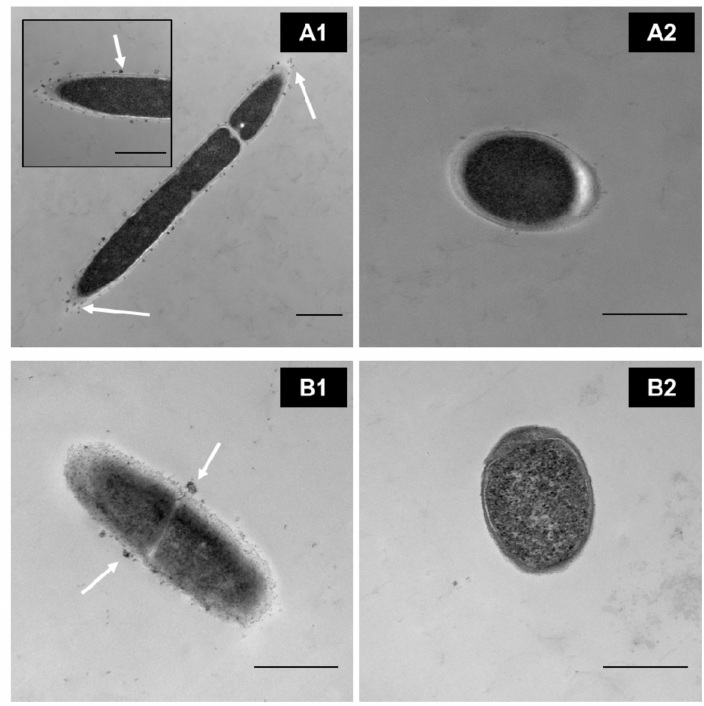
Figure 4. TEM images of washed cells grown in a defined medium supplemented with 0.5% of MPL. ( A1 ) Lactobacillus delbrueckii vs. ( A2 ) control. ( B1 ) Lactiplantibacillus plantarum vs. ( B2 ) its control. Scale bar = 500 nm. White arrows indicate MPL accumulation at the cell surface(Unpublished images, Ortega-Anaya (2020) Ohio State University, Columbus, OH, USA; personal